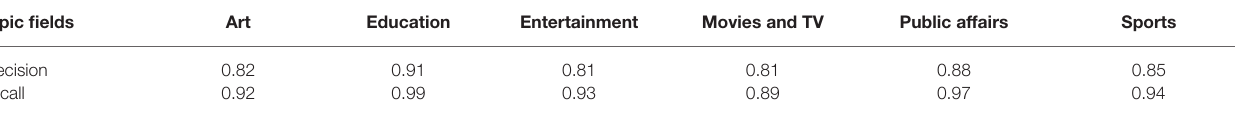
TABLE 2 | Empirical evaluation of the computational model’s effectiveness. Topic